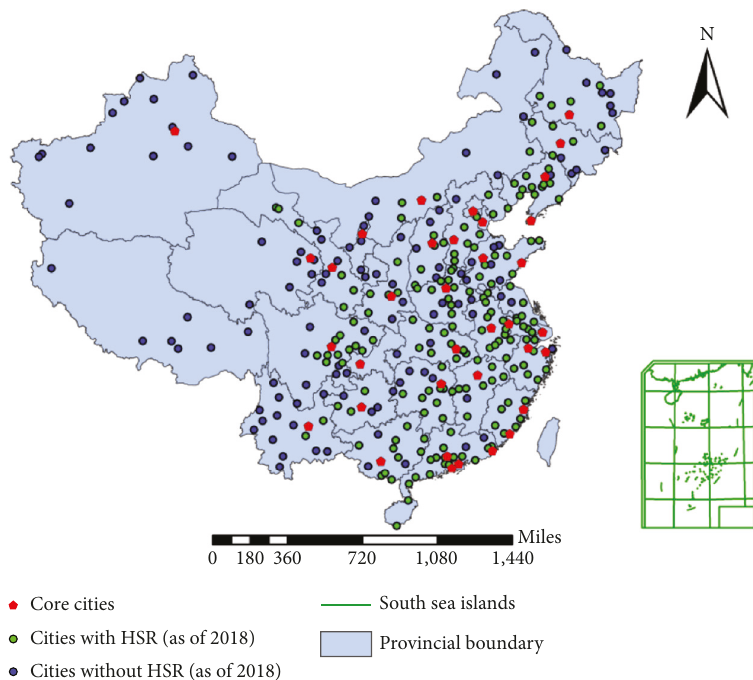
Figure 2: Distribution map of core cities and peripheral cities (as of